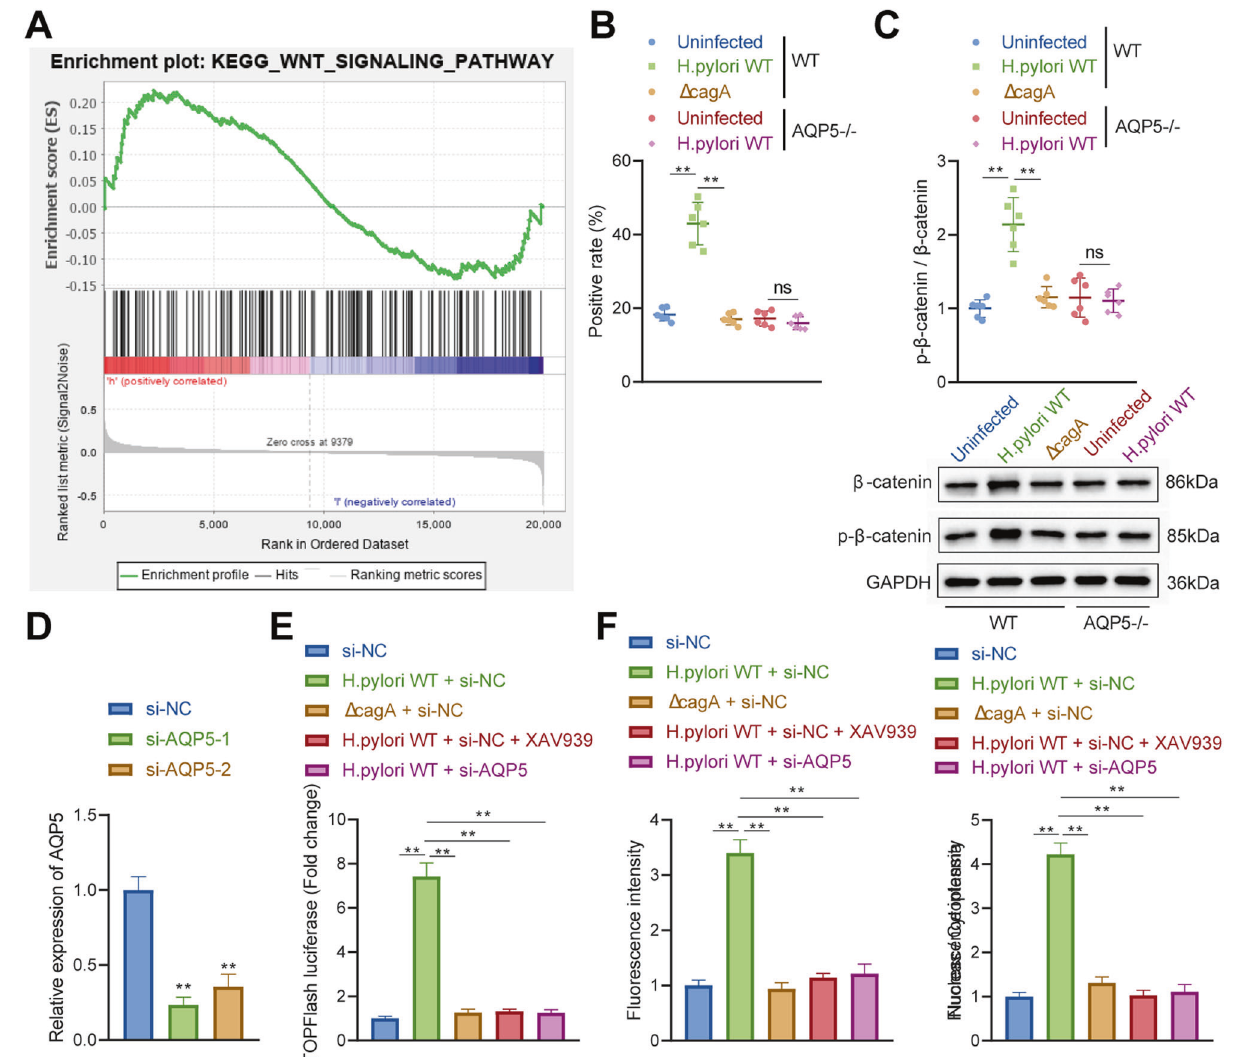
Fig. 5 H. pylori infection facilitates the activation of Wnt/ β -catenin pathway by upregulating AQP5. A The differences in enriched pathways between AQP5 high expression and low expression groups analyzed by GSEA. B β -catenin expression in gastric mucosa of mice detected by immunohistochemistry ( n = 6). C β -catenin protein level in gastric mucosa of mice detected by Western blot analysis ( n = 6). D AQP5 mRNA level in AGS cells determined by RT-qPCR. E The activation of Wnt/ β -catenin pathway in primary GECs of mice detected by TOPFlash luciferase reporter assay. F β -catenin expression in mouse primary GECs detected by immuno fl uorescence staining. * p < 0.05, ** p < 0.01, ns not signi fi cant. Data were shown as the mean ± standard deviation. Cell experiments were repeated three times independently. One- way ANOVA with Dunnett ’ s post hoc test was applied for the comparison of data among multiple